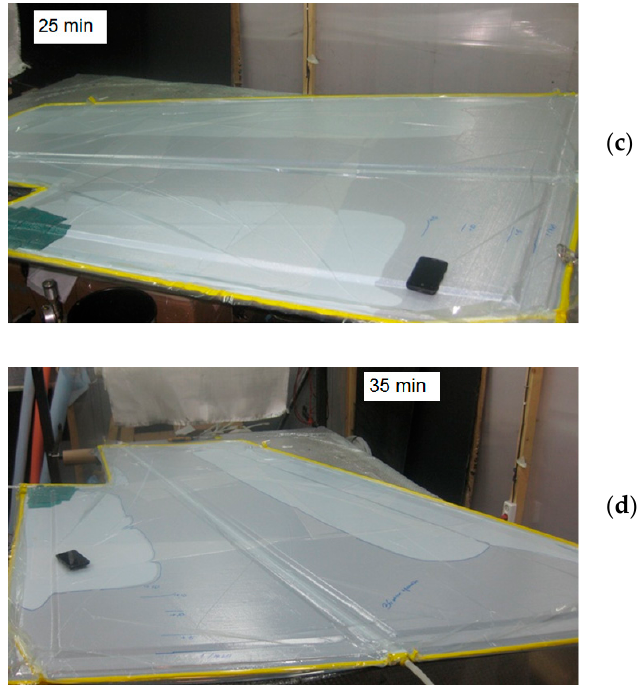
Figure 6. The spreading of the resin front at the vacuum infusion of the tail sandwich panel.